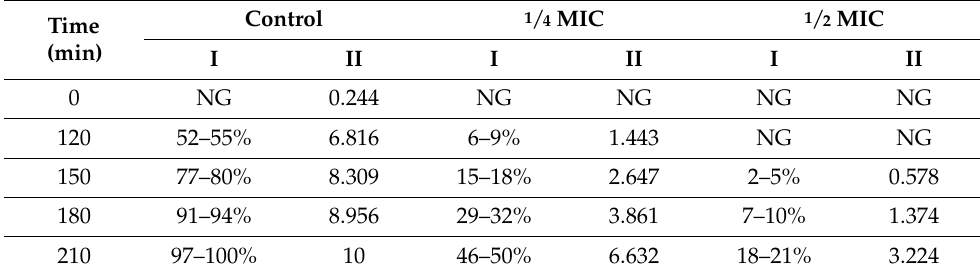
Figure 11. Inhibitory effect of bimetallic Ag-Cu NPs on yeast to hyphal transition in C. albicans . ( A ) Yeast cells recorded at 0 min; ( B ) Yeast to hyphae transition observed after growing C. albicans for 210 min in the absence of test NPs; Yeast to hyphae transition after 210 min in the presence of test NP at concentration 0.125 µ g/mL ( C ) and 0.25 µ g/mL ( D ). Table 2. Yeast to hyphal transition in the presence of Ag-Cu bimetallic